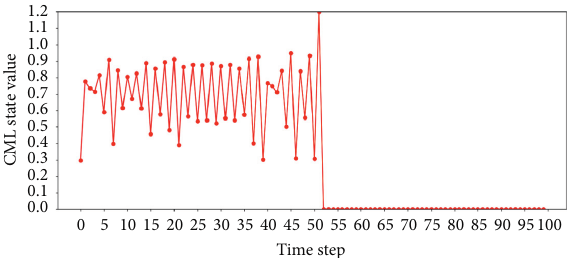
Figure 2: CML state value changes of the Dongchuan Road station with time (disturb R �